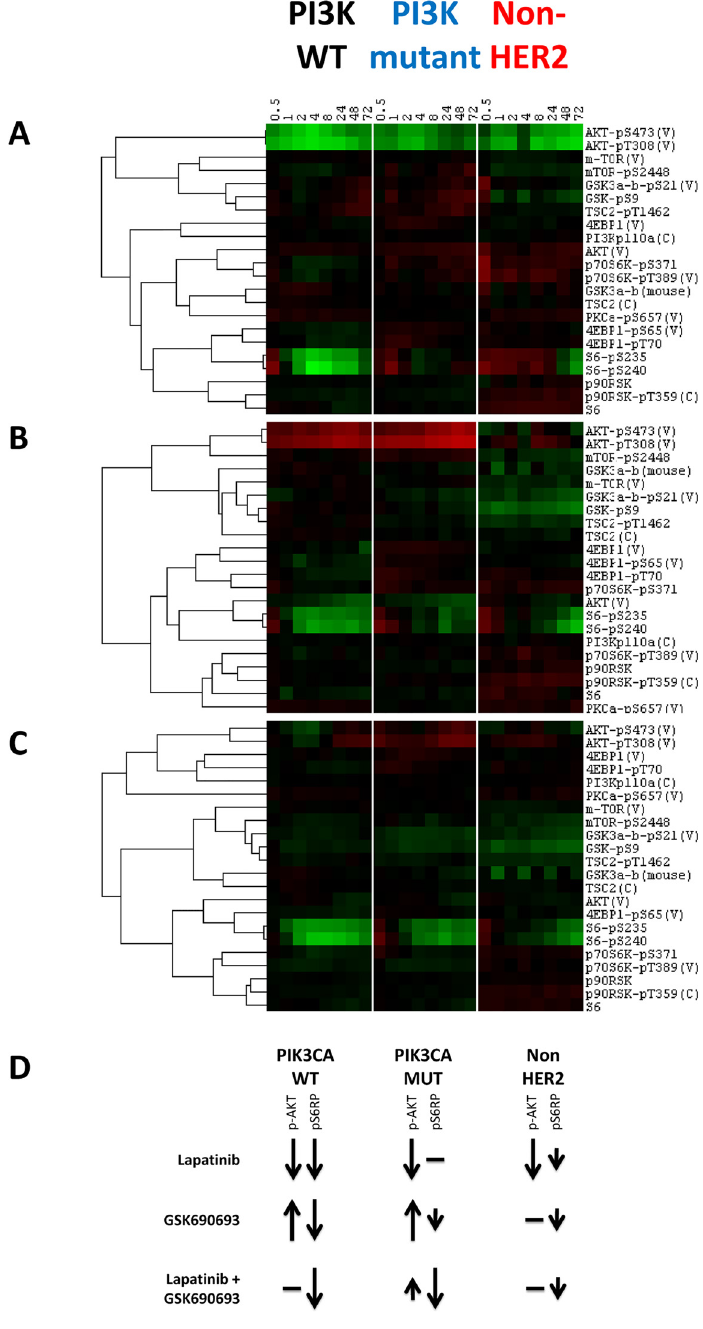
Fig 4. Heat maps showing average response within subtype (HER2 + /PIK3CA WT ; HER2 + /PIK3CA mut ; HER2 - ) to targeted therapeutics alone and in combination from RPPA data. A . Down-regulation of the PI3K-AKT pathway is evident in all HER2 + cells treated with lapatinib, irrespective of PI3K mutation status. However, the degree of down-regulation is less in cell lines with PI3K mutations (see p-S6 Ser235 for example). B . Treatment with GSK690693 leads to down-regulation of proteins downstream of AKT in all HER2 + cell lines, although the degree of down-regulation is less in lines harboring PI3K mutations. C . Treatment with the combination of lapatinib plus GSK690693 leads to down-regulation of the PI3K-AKT signaling pathway in both PIK3CA mut and PIK3CA WT lines. Note the much greater degree of down-regulation of S235 and S240 p-S6 in PIK3CA mut cell lines treated with the combination relative to the single therapies. D . A summary of the most significant changes observed in the RPPA data for the PIK3CA WT , PIK3CA mut , and non-HER2 amplified cell lines under inhibition with lapatinib, GSK690693, or a combination of the two.